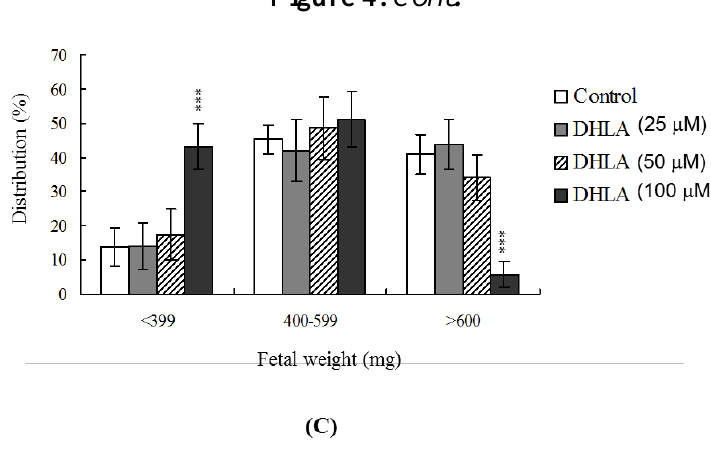
Figure 5. Effects of dietary DHLA on apoptosis and blastocyst development in an